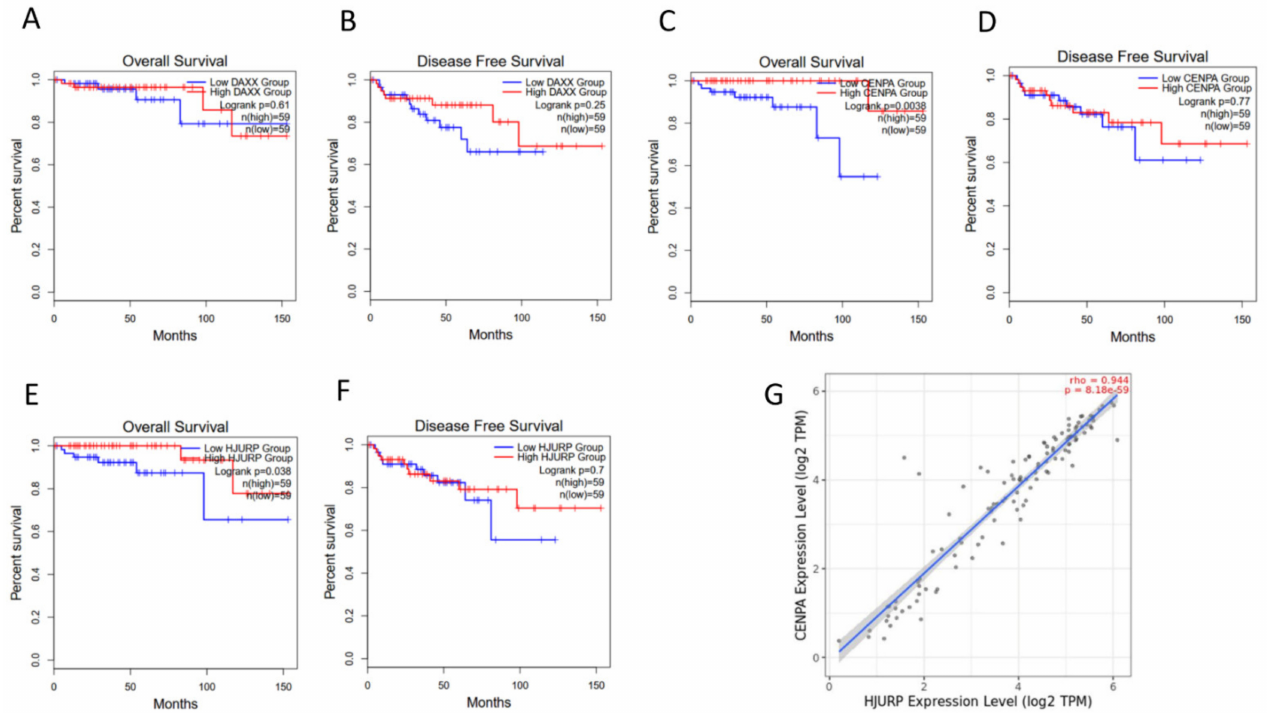
Figure 2. ( A – F ) TCGA TETs cohort survival analysis for DAXX expression ( A , B ), CENP-A ( C , D ) and HJURP ( E , F ). Survival analysis was performed with GEPIA2, using median as a cutoff. ( G ) TiMER2.0 analysis of TCGA TETs expression profile revealing a strong correlation between the expression of CENP-A and